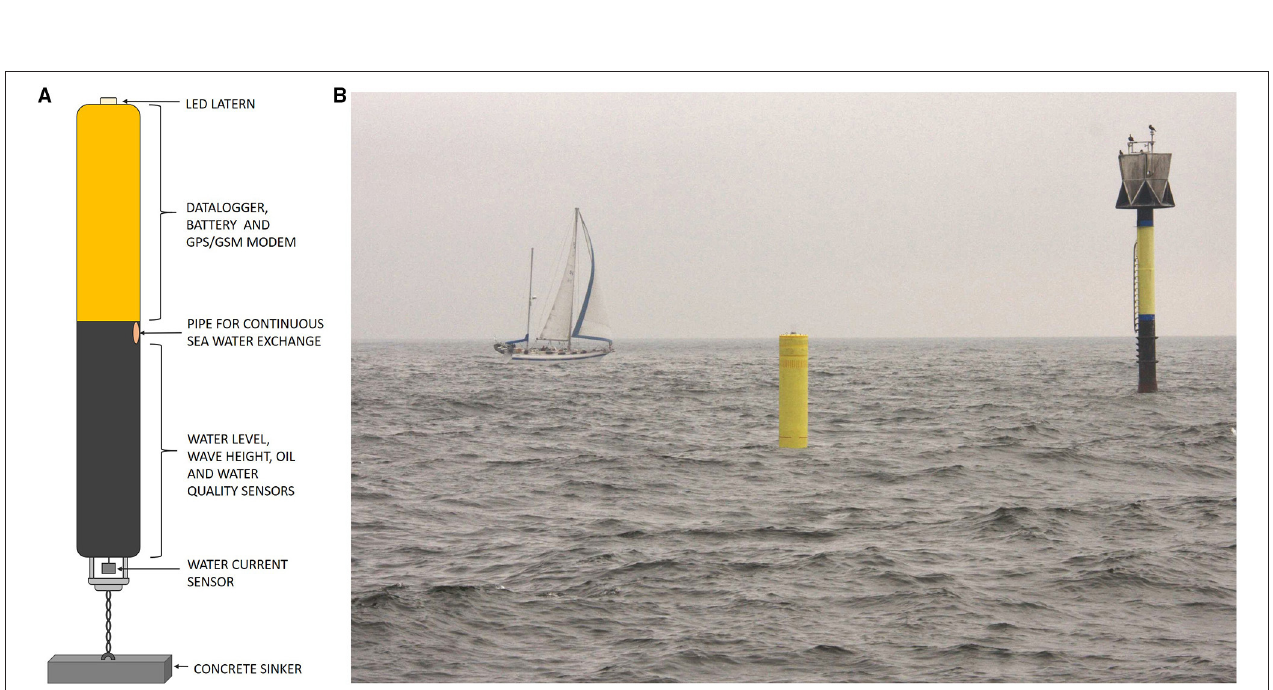
FIGURE 5 | Schematic figure of the SmartBuoy system (A) and the SmartBuoy deployed to the off-shore area in the Gulf of Finland for oil spill detection (B) . Photograph: Joose Mykkänen.